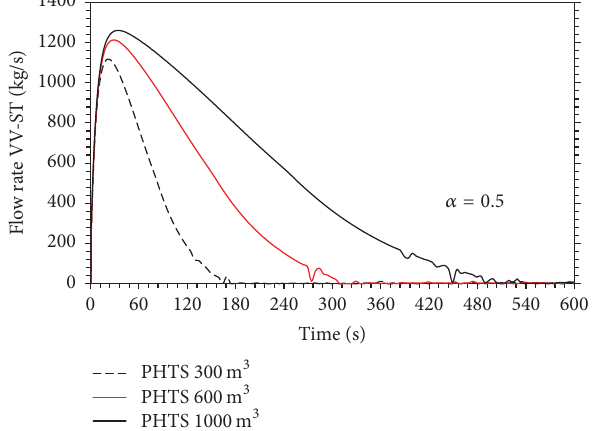
Figure 8: Flow rate through the relief and vent pipes (total area 1.2 m 2